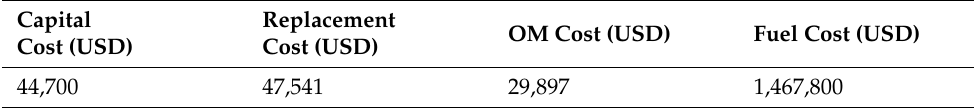
Table 10. Cost summary of the DG-only system.